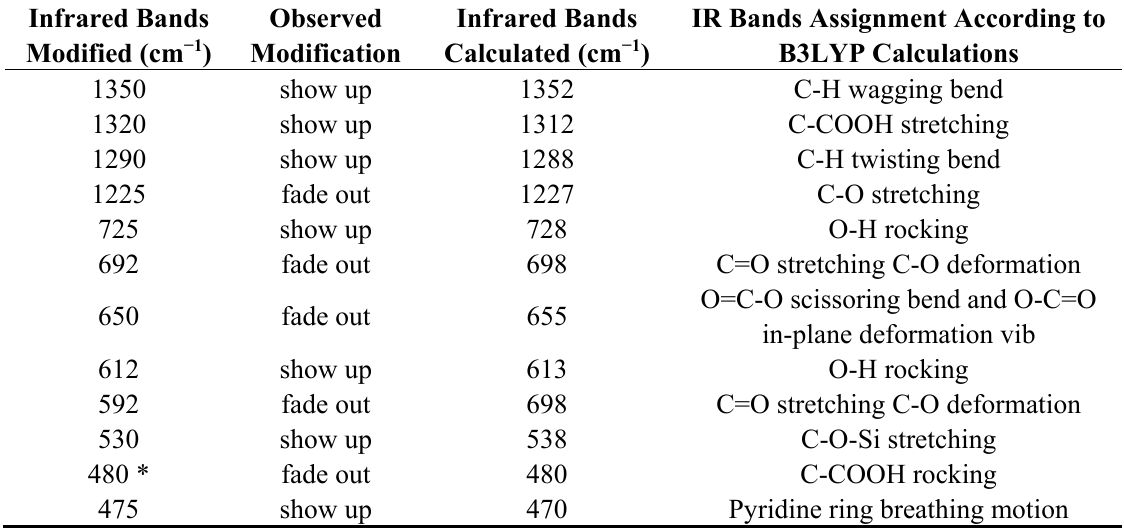
Table 4. Modification FTIR bands observed and tentative assignment for Beta vulgaris modified